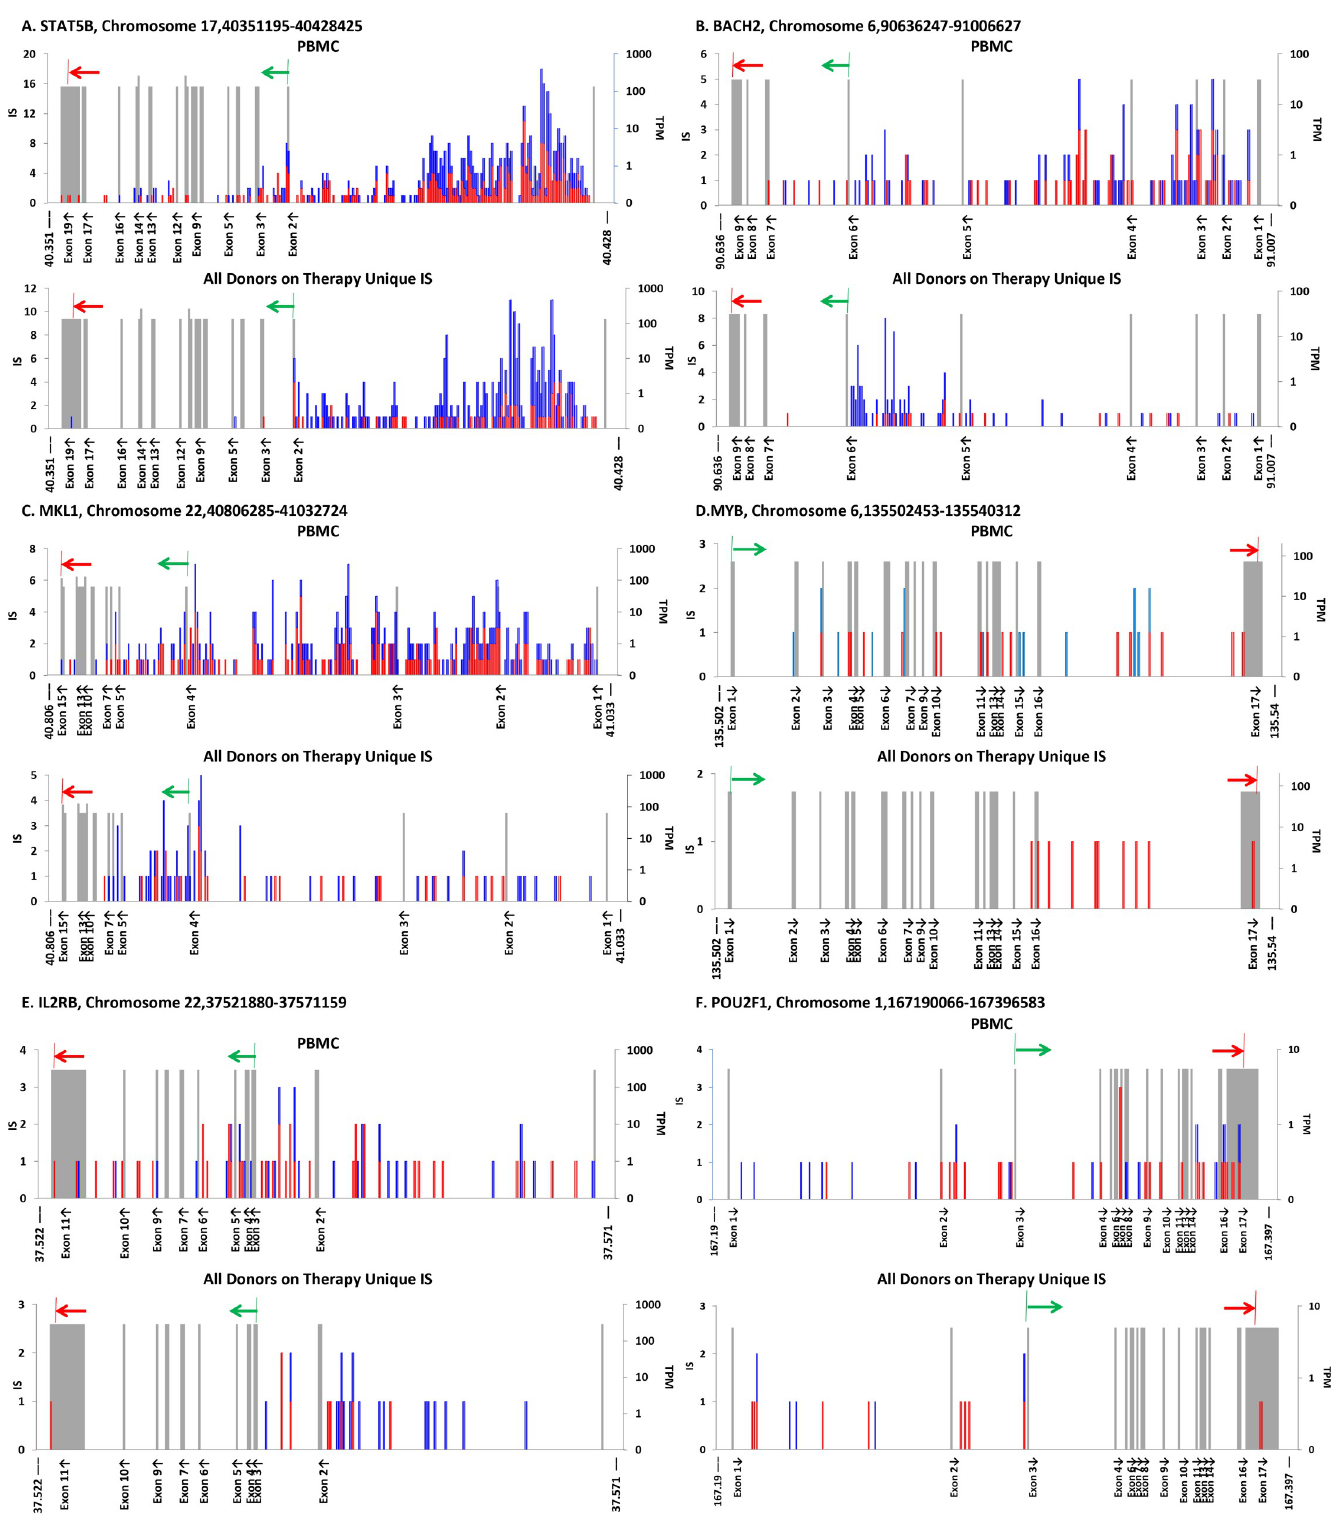
Fig 5. HIV IS in other genes in which proviruses can give the host cell a selective advantage. Maps were generated for each of the genes in Table 3 as described in Fig 4. For each pair of panels, the map at the top shows the IS distribution for the PBMC infected in vitro, and the on-ART distribution is at the bottom A. STAT5B (309 bp/bin). B. BACH2 (1.48 kb/bin). C. MKL1 (906 bp/bin). D. MYB (151 bp/bin). E. IL2RB (197 bp/bin) F. POU2F1 (828